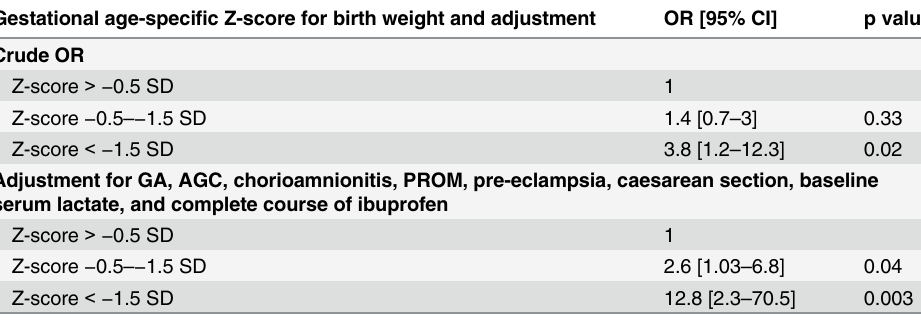
Table 3. Risk of failure of the first course of